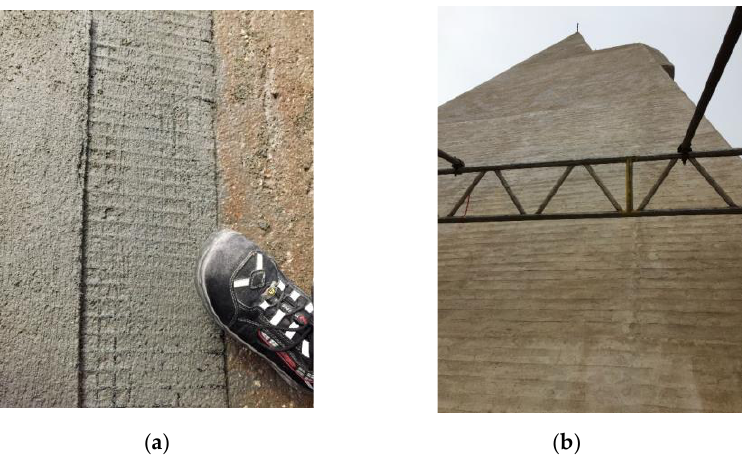
Figure 2. Sealing (layer by layer) the roof of Mariendom Neviges with TRC (© Jeanette Orlowsky): ( a ) part of repair layer with TRC; ( b ) general view of the repaired surface.